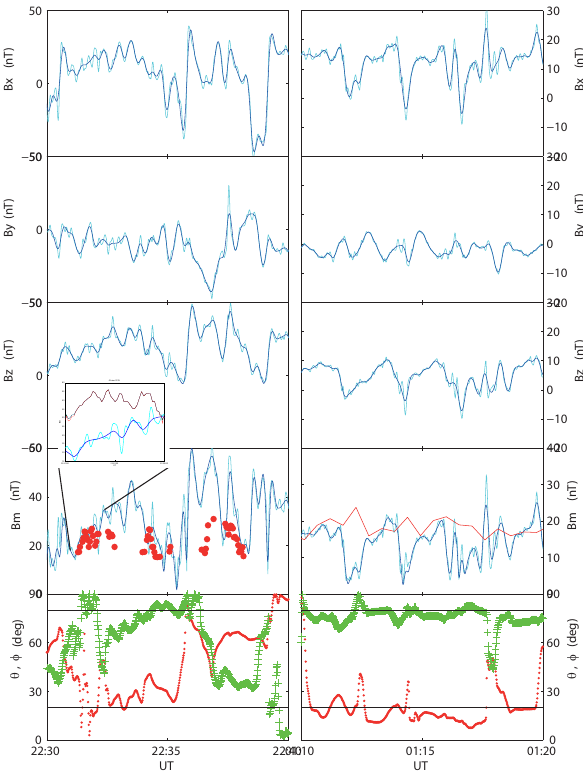
Figure 8. (a) The IES electron and ion density. (b–e) The mag- netic field components and field strength in black and the band-pass filtered data in red. (f) The (cid:49)B/B from the MM identification pro- cedure. (g) Angles θ (green) and φ (red) between the background magnetic field the minimum variance and the maximum variance direction respectively.